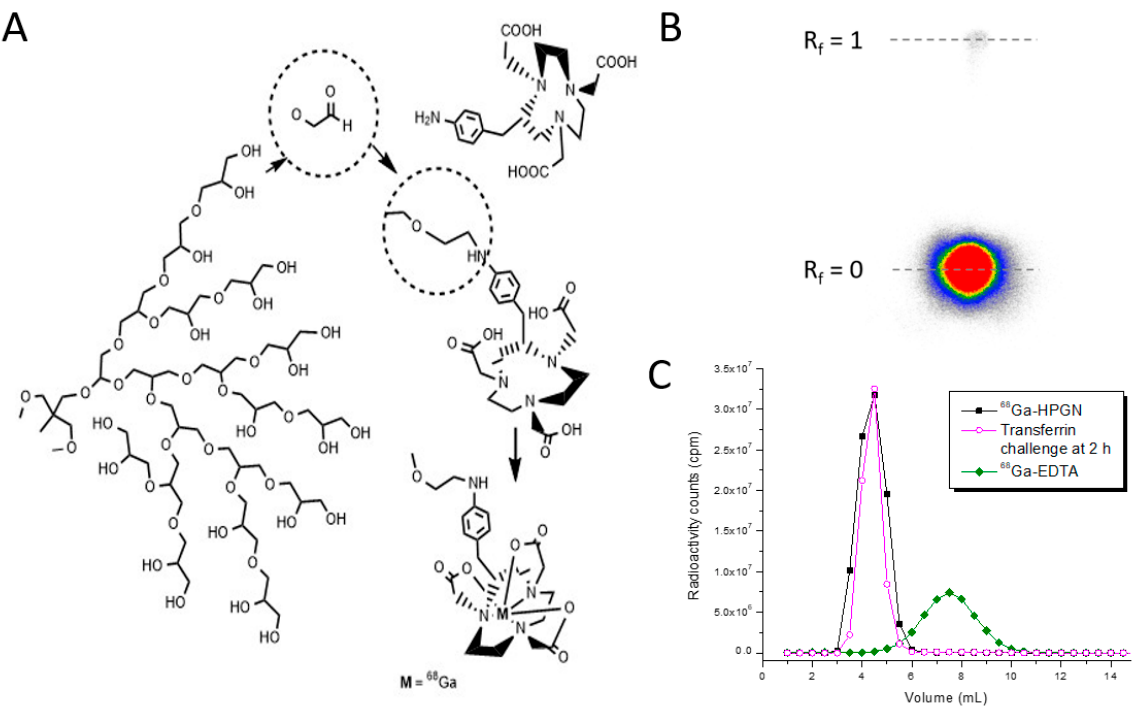
Figure 1. ( A ) Schematic synthesis of 68 Ga-HPG. ( B ) Radiolabeling efficiency measured by thin-layer chromatography was above 99%. In the mobile phase mixture (33.3% each of saline, 0.1 M HCl, and 0.1 M Na 2 EDTA), the free 68 Ga chelated by EDTA moved to the front, while the radiolabeled 68 Ga-HPG stayed at the origin. ( C ) Size-exclusion chromatography (GPC) was used to measure the stability of 68 Ga-HPGN. Only a single peak (black) was measured. A challenge with transferrin at 100 × excess proved the very high stability of the product—no 68 Ga was transchelated to the position where 68 Ga-transferrin or 68 Ga-EDTA was found at ~8